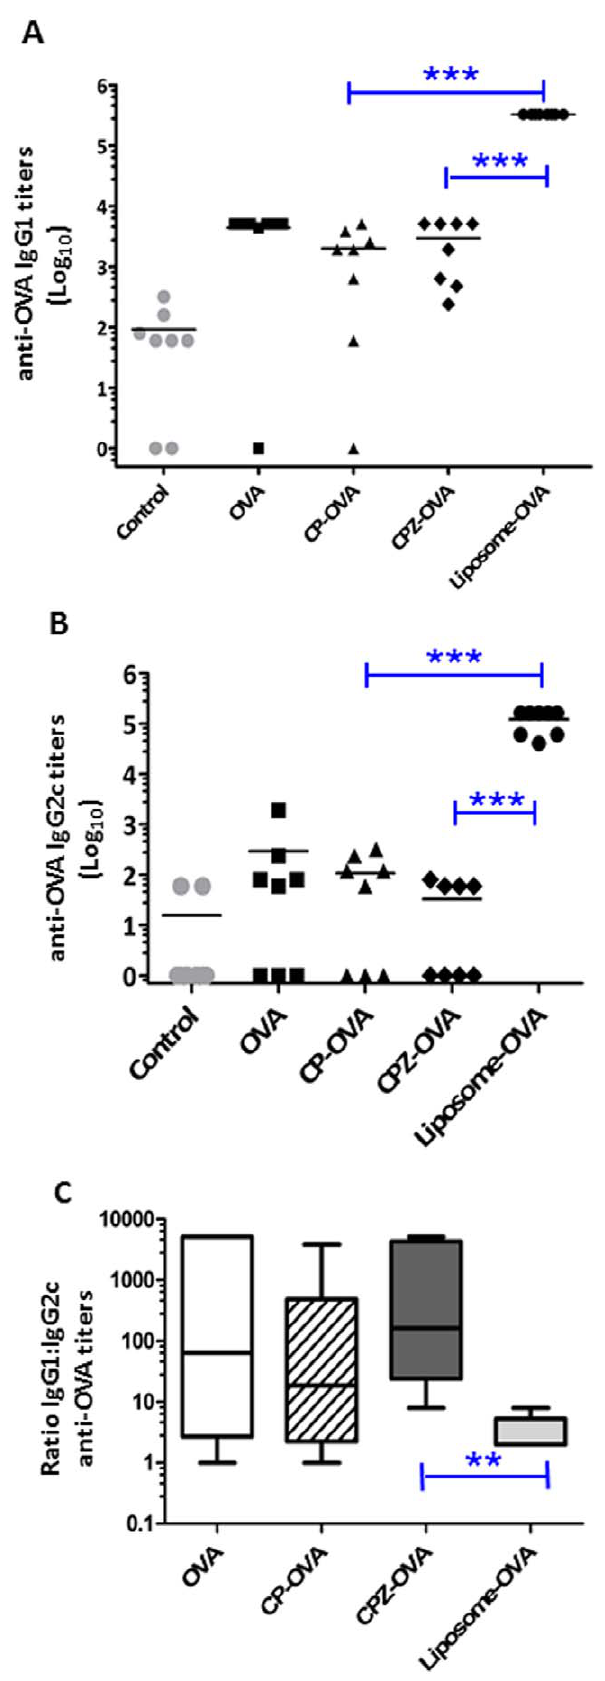
Figure 7. Vault nanocapsules produce lower anti-OVA anti- N body titers. Antibody titers after vaccination schedule, composed of 3 N ), unencapsulated OVA in weekly s.c. injections with control saline ( saline ( & ), CP-OVA ( m ), CPZ-OVA ( X ) or Liposome-OVA ( ). (A) Total anti-OVA-IgG1 titers and (B) Total anti-OVA-IgG2c titers. Significance was determined by ANOVA (p , 0.001) with Bonferroni post-hoc test (***p , 0.001). (C) Ratio of anti-OVA IgG1 to IgG2c antibody. The ratio of Liposome-OVA immunized mice were compared to the other OVA- immunized groups using Mann Whitney t-test (*p , 0.001). Data are representative of 2 independent